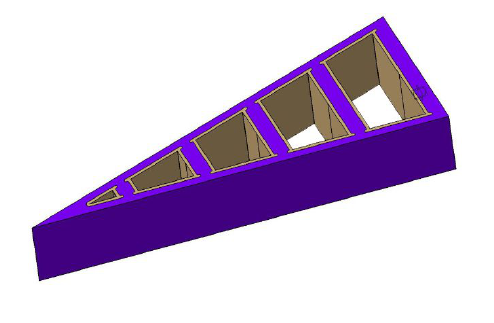
Figure 3. The draft for stern models A and B (in violet) with braces (in beige) to create the stiff configuration of the stern